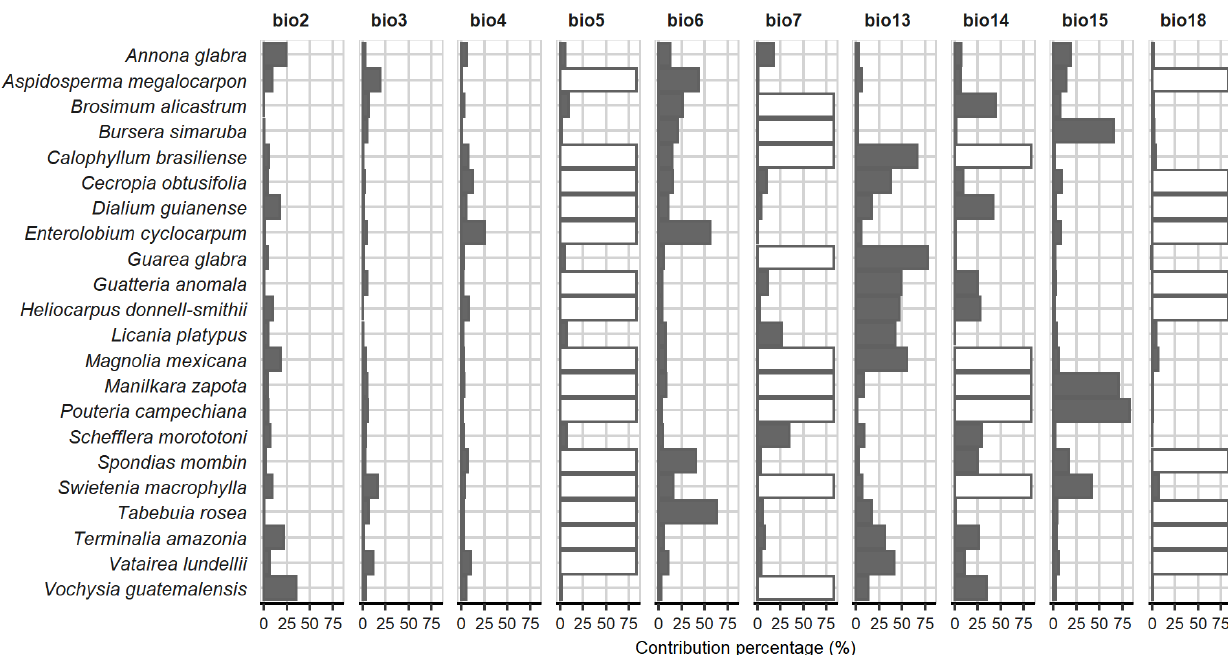
Figure 1. Contribution of bioclimatic variables to the Maxent models. White bars indicate variable not used. (BIO1 = Annual mean temperature, BIO2 = Mean diurnal range, BIO3 = Isothermality, BIO4 = Maximun temperature of warmest month, BIO6 = Minimun temperature of coldest month, BIO7 = Temperature annual range, BIO8 = Mean temperature of wettest quarter, BIO9 = Mean temperature of driest quarter, BIO10 = Mean temperature of warmest quarter, BIO11 = Mean temperature of coldest quarter, BIO12 = Annual precipitation, BIO13 = Precipitation of wettest month, BIO14 = Precipitation of driest month, BIO15 = Precipitation seasonality, BIO16 = Precipitation of wettest quarter, BIO17 = Precipitation of driest quarter, BIO18 = Precipitation of warmest quarter and BIO19 = Precipitation of coldest quarter).